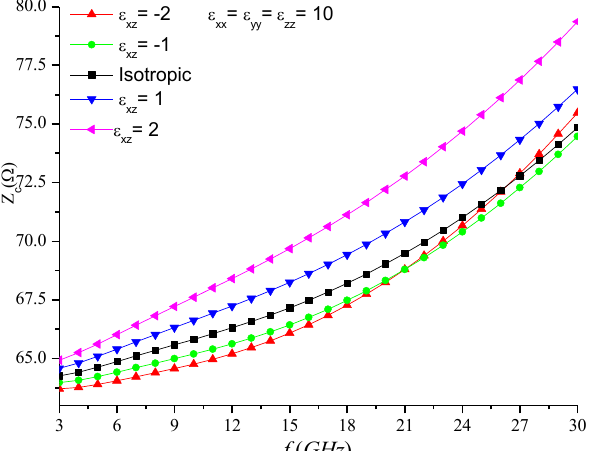
Figure 9.b: Effect real valued e impedance